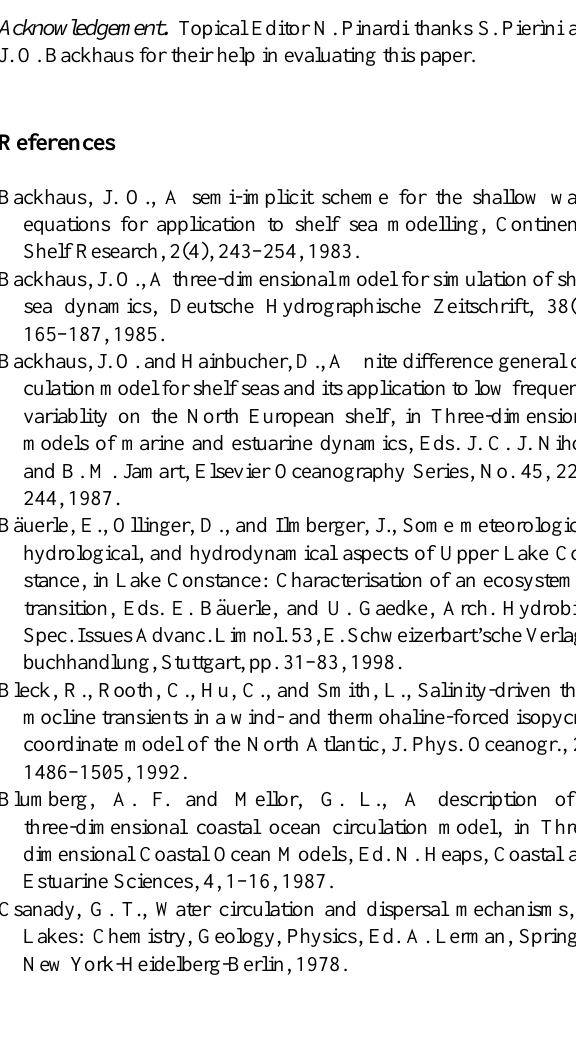
FIG. 26: Time series of the horizontal velocity components u (a) and v (b) at the center of the Obersee Fig. 26. Time series of the horizontal velocity components (a) u and (b) v at the center of the Obersee subject to the wind forcing of Fig. 22, subject to the wind forcing of Fig. 22, where the Coriolis force is not considered. The labels indicate the where the Coriolis force is not considered. The labels indicate the depths in depths in meters